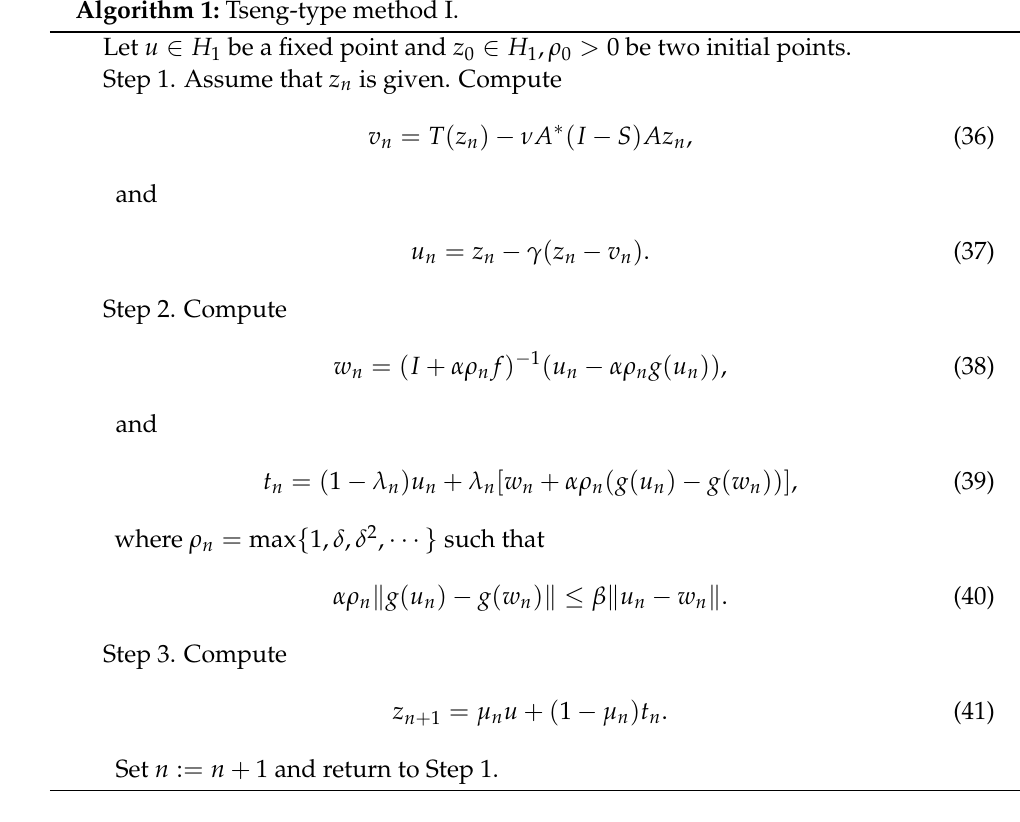
Algorithm 1: Tseng-type method